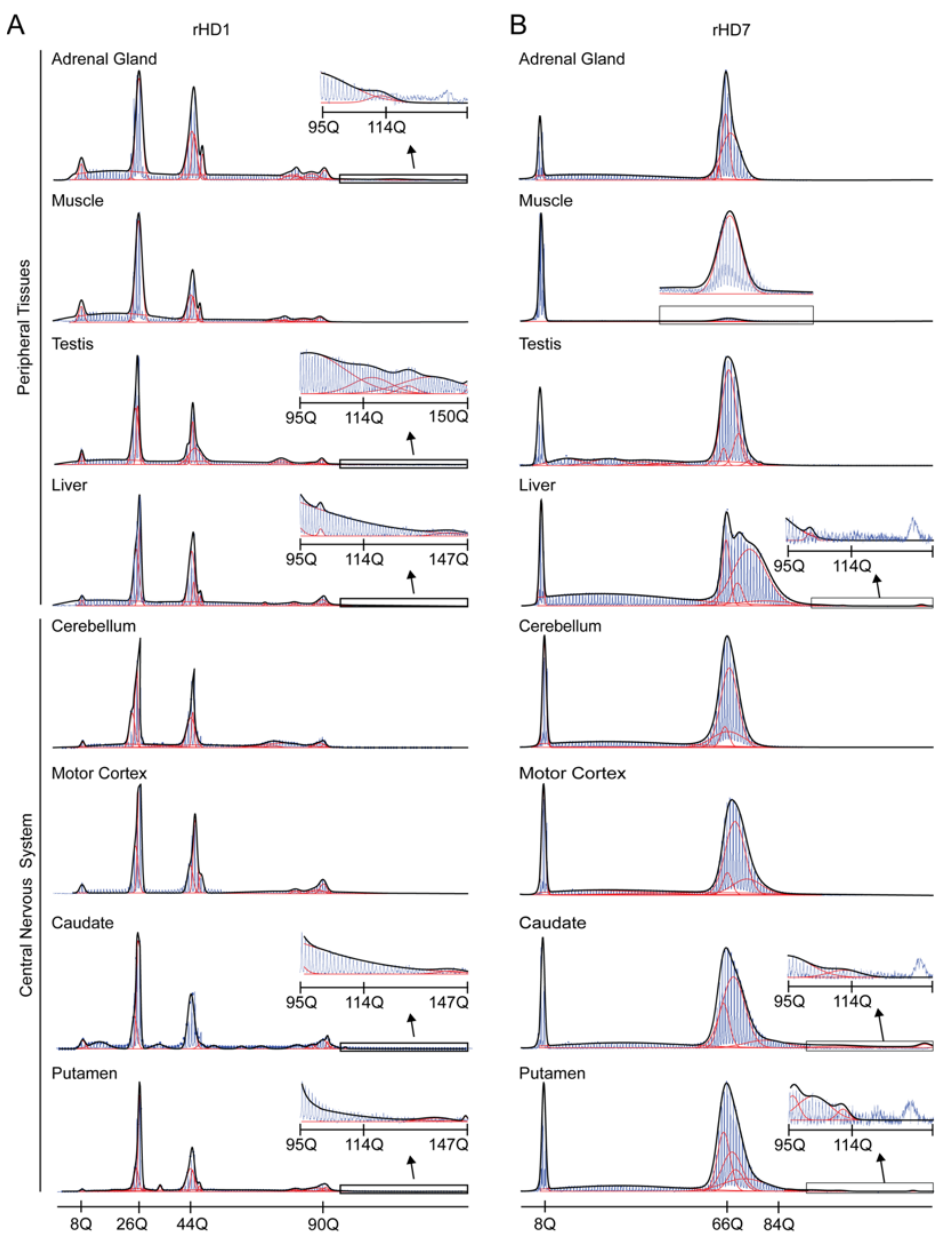
Figure 1. Representative electropherograms superimposed with curve-ft results of rHD1 and rHD7. ( A ) In rHD1, testis and liver showed the highest expansion among peripheral tissue samples, while caudate and putamen showed the highest expansion among the central nervous system tissue samples. ( B ) In rHD7, the liver showed the highest expansion among the peripheral tissue samples, and caudate and putamen showed the largest expansion among the central nervous system tissue samples. In both rHD1 and rHD7 tissue samples, the muscle was the most stable tissue samples among all tissue samples collected and used as a reference when calculating the expansion index. Red lines represent individual curves and black lines represent overall curve-fit results.